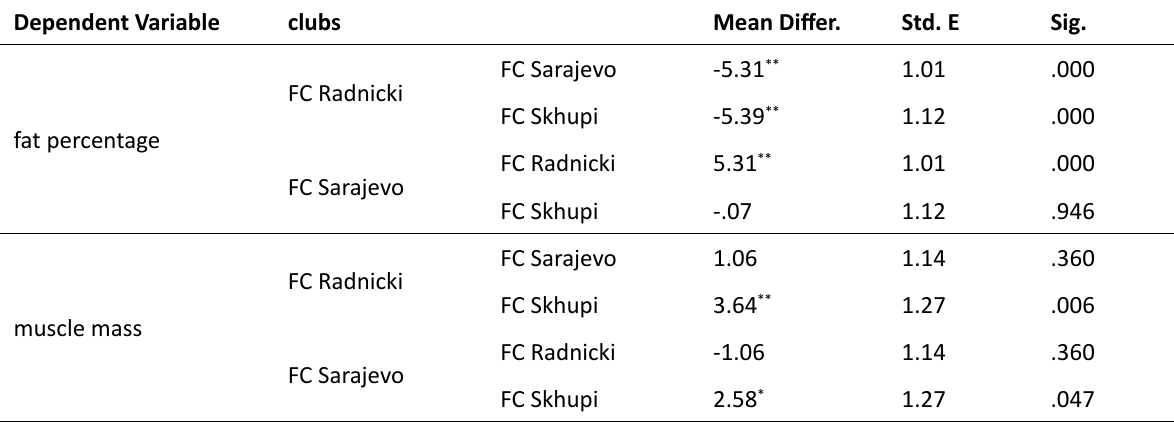
Table 2. LSD Post Hoc tests Dependent Variable